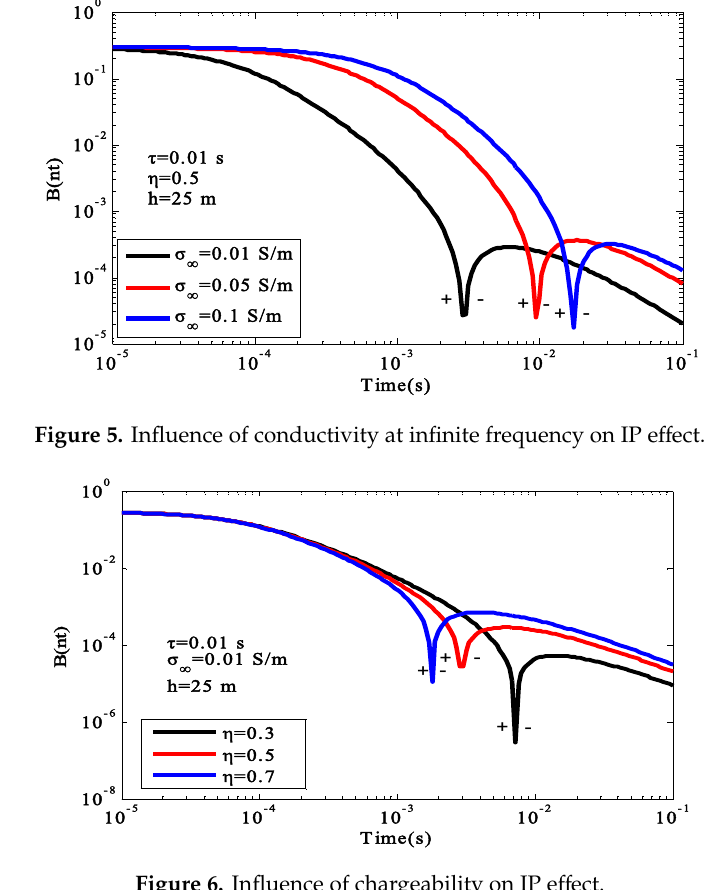
Figure 6. Influence of chargeability on IP effect.